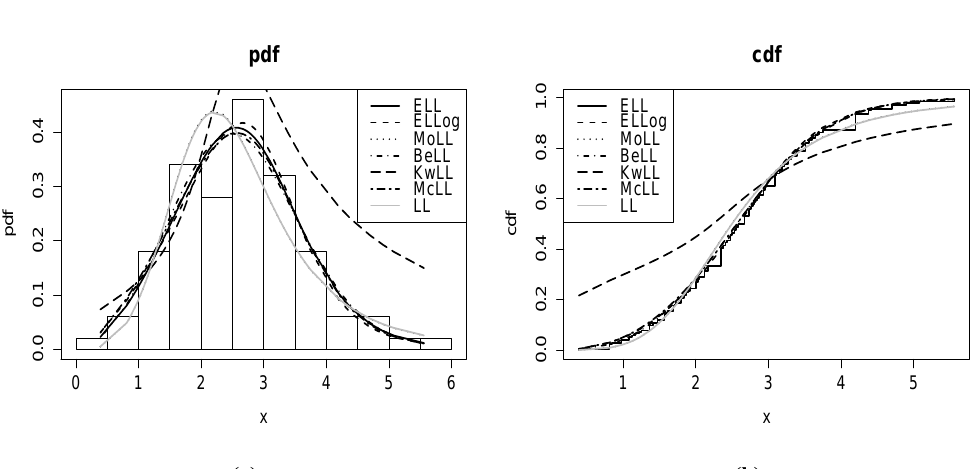
Figure 4 - Estimated pdfs and cdfs of the ELL,ELLog, McLL, BeLL, KwLL, MoLL and LL distributions fitted to the data from Nichols and Padgett